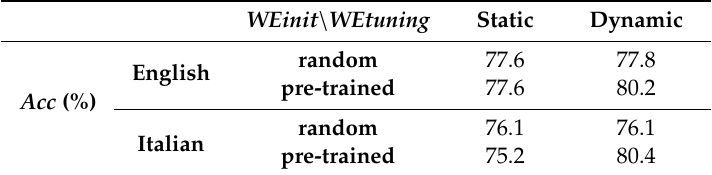
Table 6. Testing accuracy obtained by di ff erent Word Embedding (WE) initialization and fine-tuning strategy 1